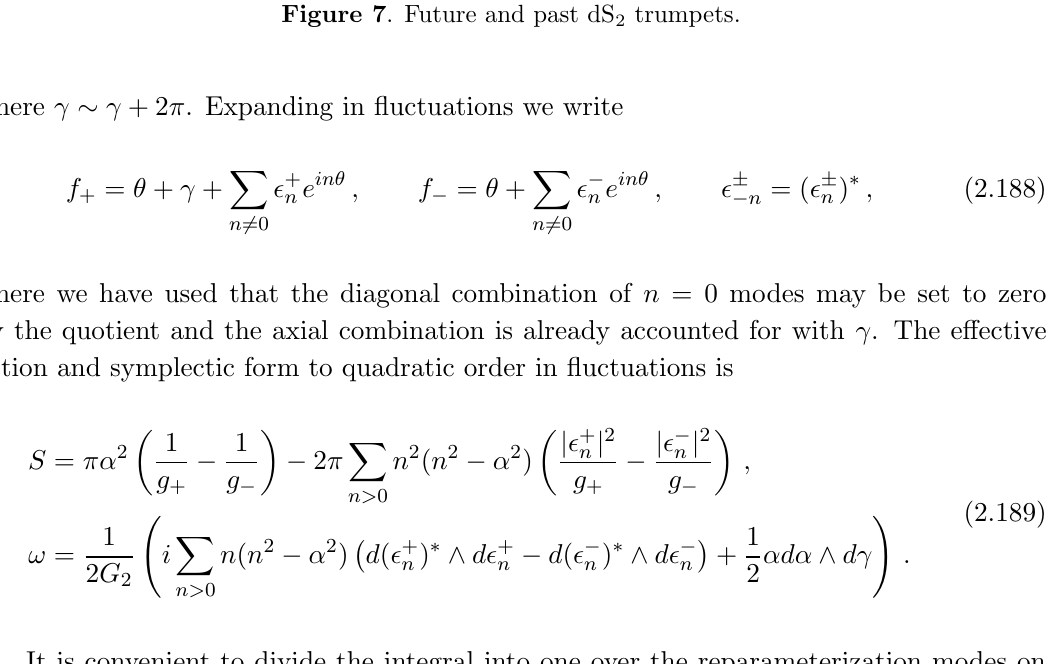
Figure 7 . Future and past dS 2